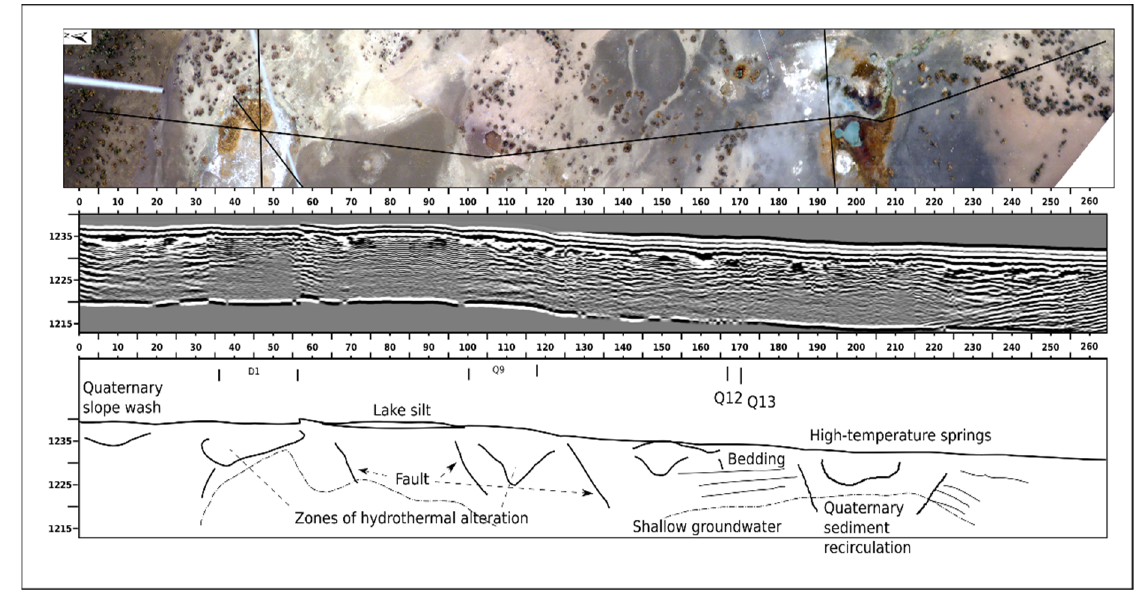
Figure 18. GPR transect 2 from north to south crossing sinter feature D1, the west flank of the sinter apron of Q9, and the Figure 19. GPR transect 3 from west to east across the high-temperature area of Mickey Springs. An unconformity underlies high ‐ temperature spring area, terminating at the south fence of the ACEC. Three normal faults are interpreted from the the unvegetated area of the high-temperature springs. Thick peaks and undulating bedding may indicate the location of GPR data, striking northeast. These faults control the elevation of the topographic bench at 1235 m and may provide fluid pathways for surface springs (Figure S4: GPR raw data and topographically corrected data for Track 3, 50 permeable pathways for the spring water (Figure S3: GPR raw data and topographically corrected data for Track 2, 50 MHz). Figure 19. GPR transect 3 from west to east across the high ‐ temperature area of Mickey Springs.